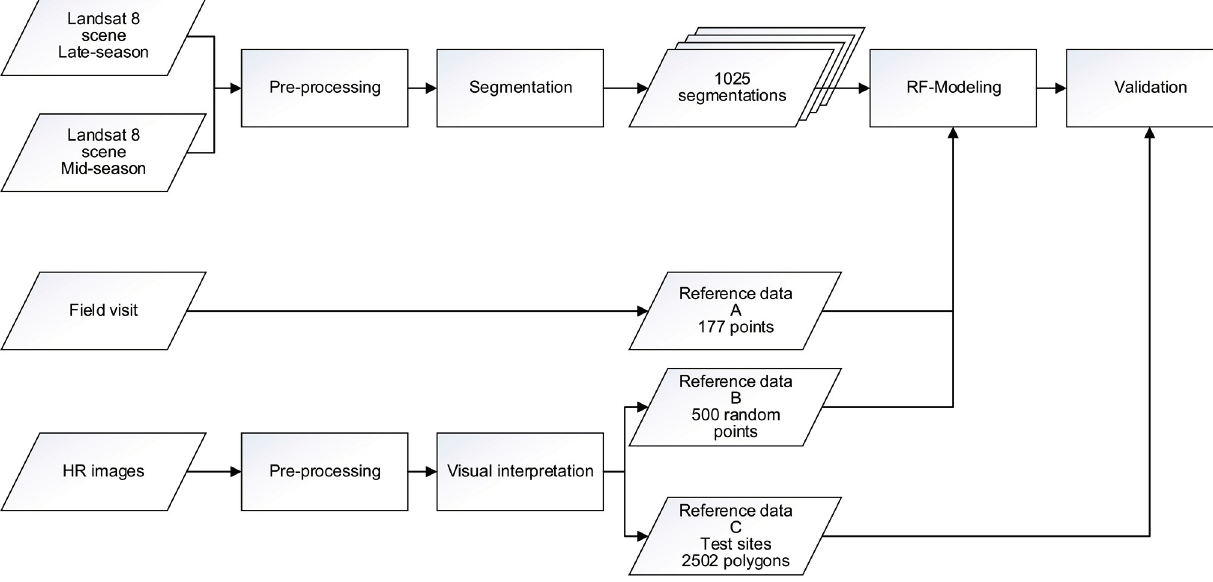
Figure 5. Flowchart of the methodology applied in this